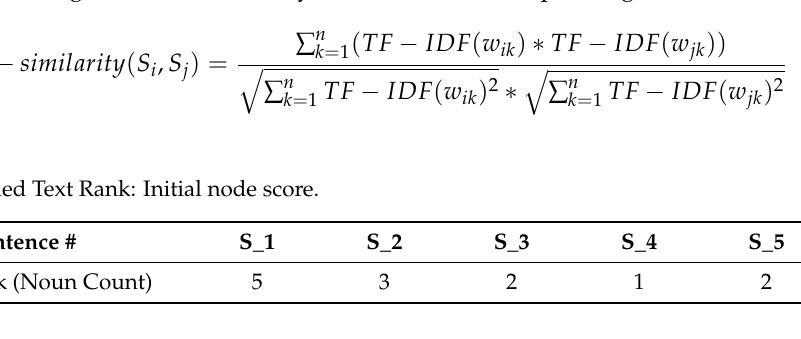
Table 3. Modified Text Rank: edge